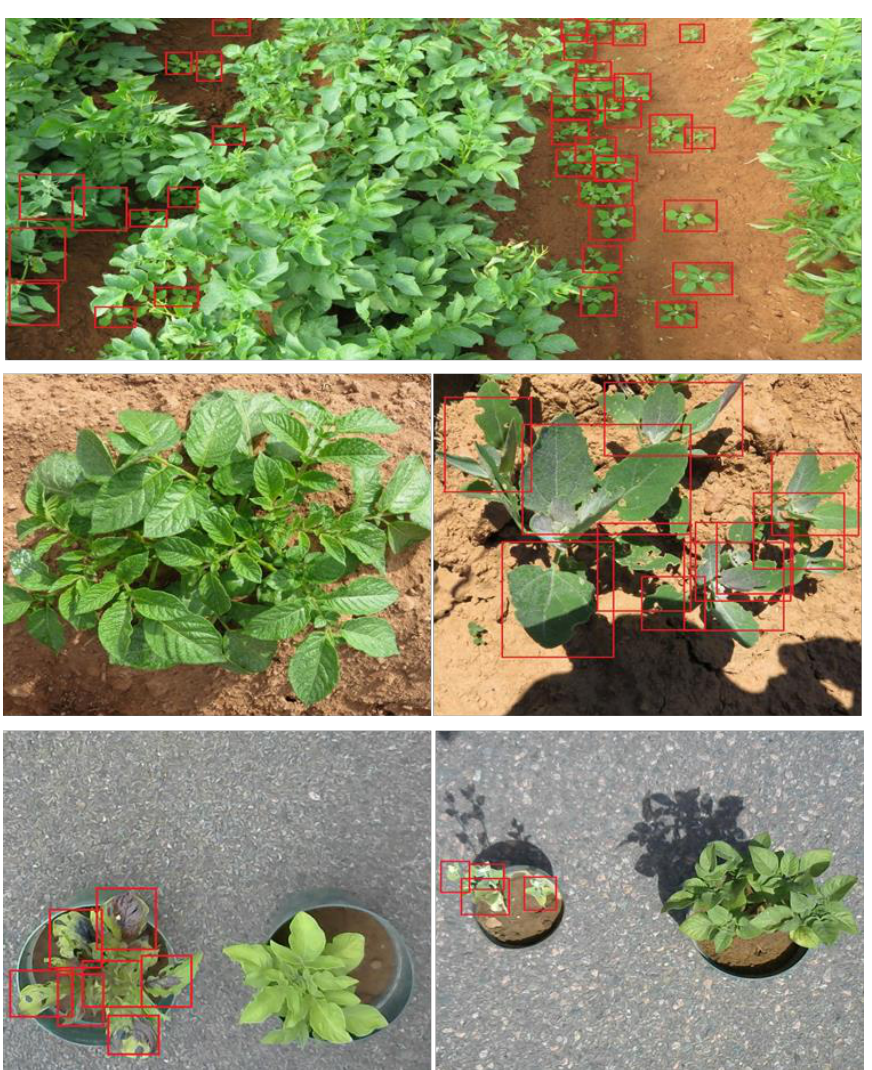
Figure 4. Processed images of lambsquarters, simulated diseased, and healthy potato plants.